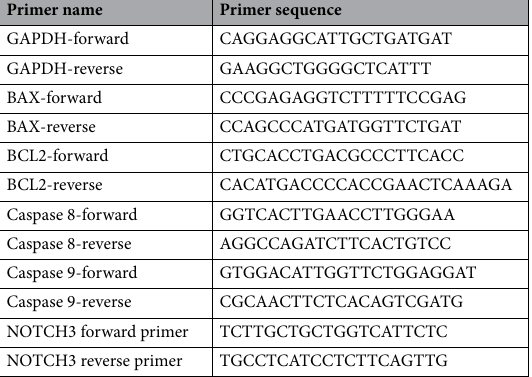
Table 2. Details of primers used in RT qPCR to assess the gene